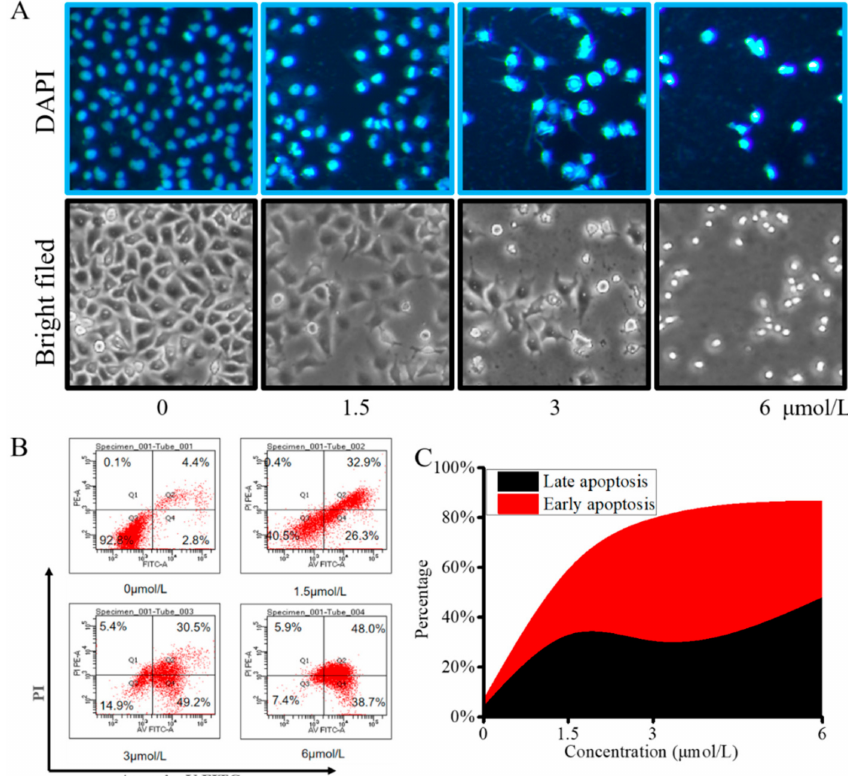
Figure 6. Compound 13e induced cell apoptosis. ( A ) Cell nucleus (upper panel) and morphology (lower panel) of compound 13e treated (48 h) or untreated MGC-803 cells; ( B ) Compound 13e induced apoptosis of MGC-803 cells. After incubated with compound 13e for 48 h, MGC-803 cells were detected by Annexin V / PI with flow cytometric analysis. The Q3 represents live cells, Q4 represents early / primary apoptotic cells, Q2 represents late / secondary apoptotic cells and Q1 represents cells necrosis. ( C ) The percentage of apoptosis (early and late apoptosis) cells increased dependently with various concentrations of compound 13e . Date are represented as mean ± SD of three independent